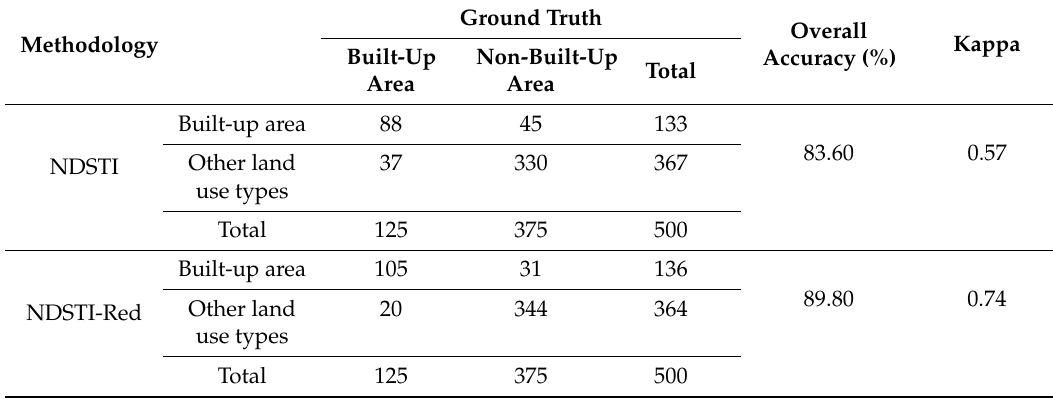
Table 4. Confusion matrix of the experimental study area (units: pixels).